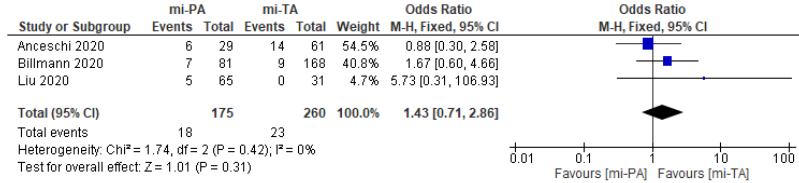
11 of 17 ( c ) Forest plot representing analysis of patients with absent clinical success according to PASO criteria.